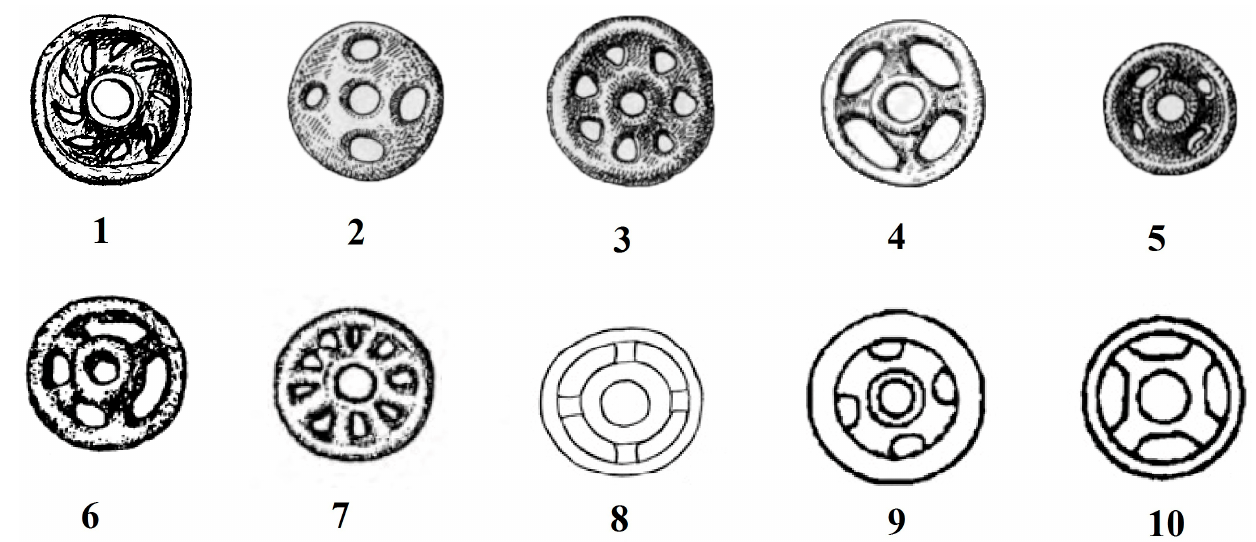
Figure 11. Bronze wheel. 1—Jal-Aryk burial ground, Ketmen-Tyube Valley, western Tien Shan; 2–5—Sauromat culture, South Urals; 6–7—Kamenskaya culture, forest-steppe Altai; 8–10—northern Xinxiang (1—after K. I. Tashbaeva (2011); 2–5—after K. F. Smirnov (1964); 6—after V. A. Mogilnikov (1997); 7—Umansky et al. (2005); Figure 10(8–10)—after P. I. Shulga